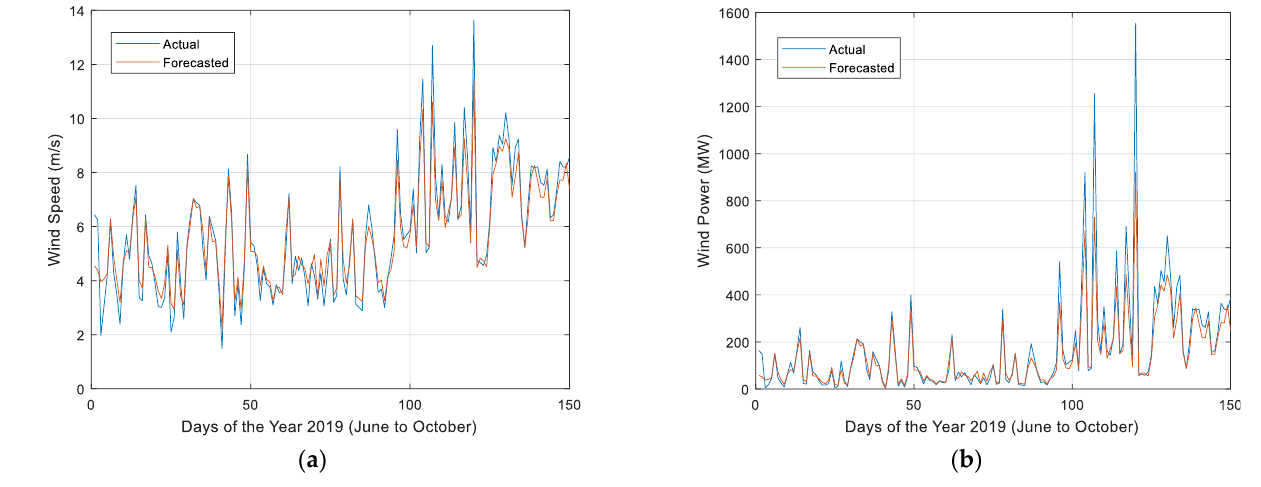
Figure 10. ( a ) Comparative analysis of wind speed forecasting by the FFNN trained through MHPSO-BAAC. ( b ) Comparative analysis of aind power forecasting by the FFNN trained through MHPSO-BAAC.